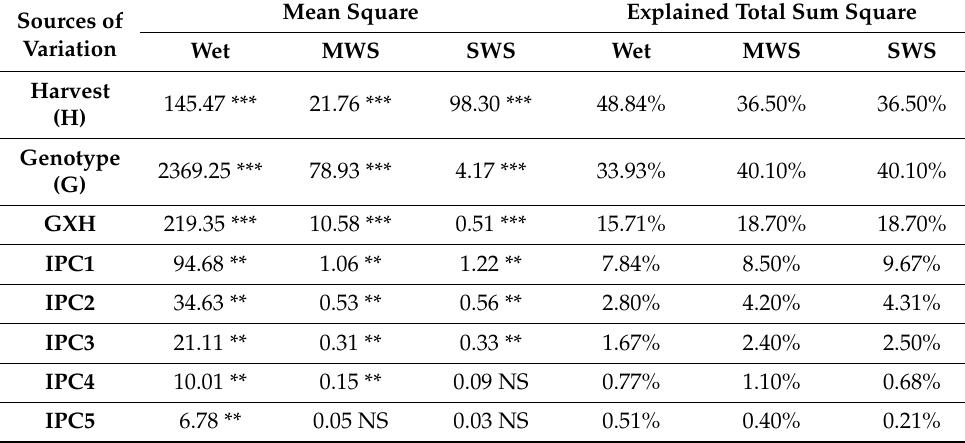
Figure A1. Relationship for individual genotypes between total dry weight (TDW) during the wet season and: ( A ) TDW under moderate water stress (MWS); ( B ) TDW under severe water stress (SWS) conditions. Table A4. AMMI table for agro-morphological traits of Napier grass genotypes grown under rainy season (wet), moderate water stress and severe water stress conditions. Mean Square Explained Total Sum Square Sources of Variation